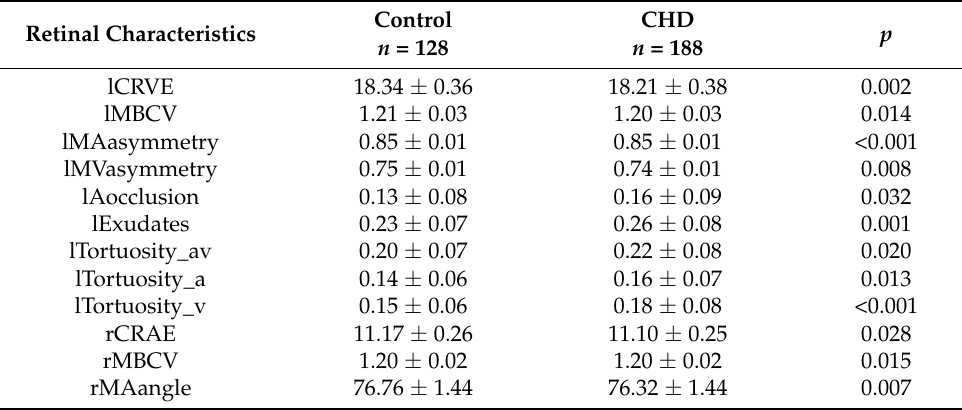
Table 2. Comparison of retinal characteristics between CHD and Control.